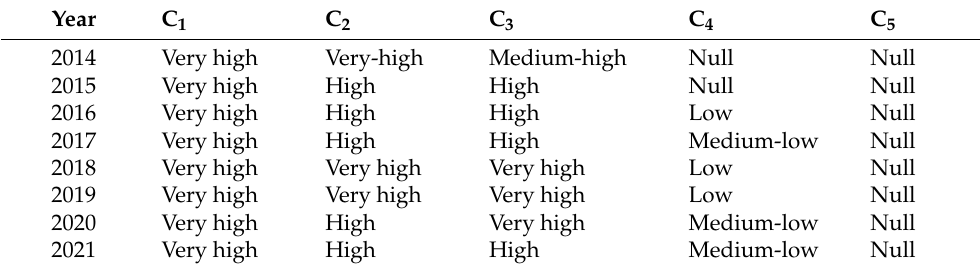
Table 7. Municipality 2 category relevancies measured annually from 2014 to